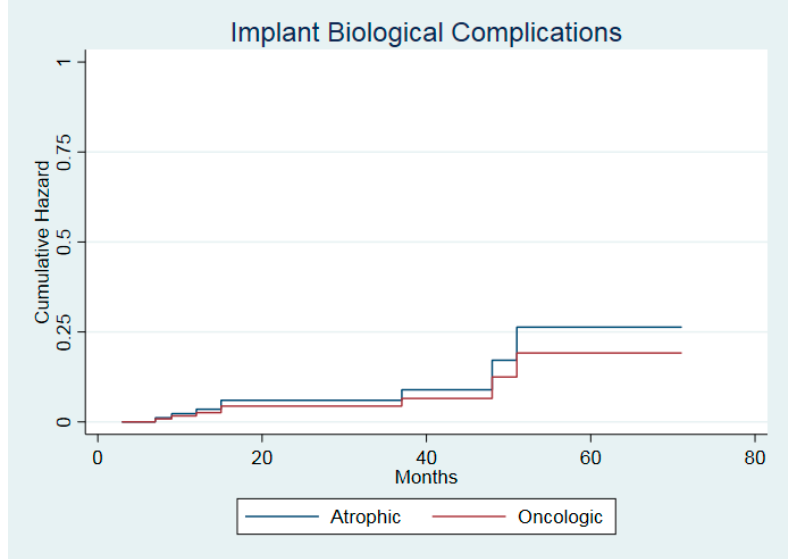
Figure 6. Hazard function of implant biological complications in the two cohorts.